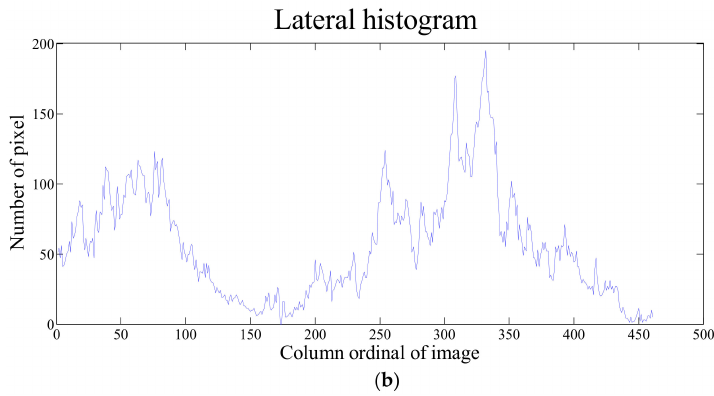
Figure 8. Lateral histogram of field images: ( a ) Pixel lateral histogram of Figure 7(a4); ( b ) Pixel lateral histogram of Figure 7(b4).